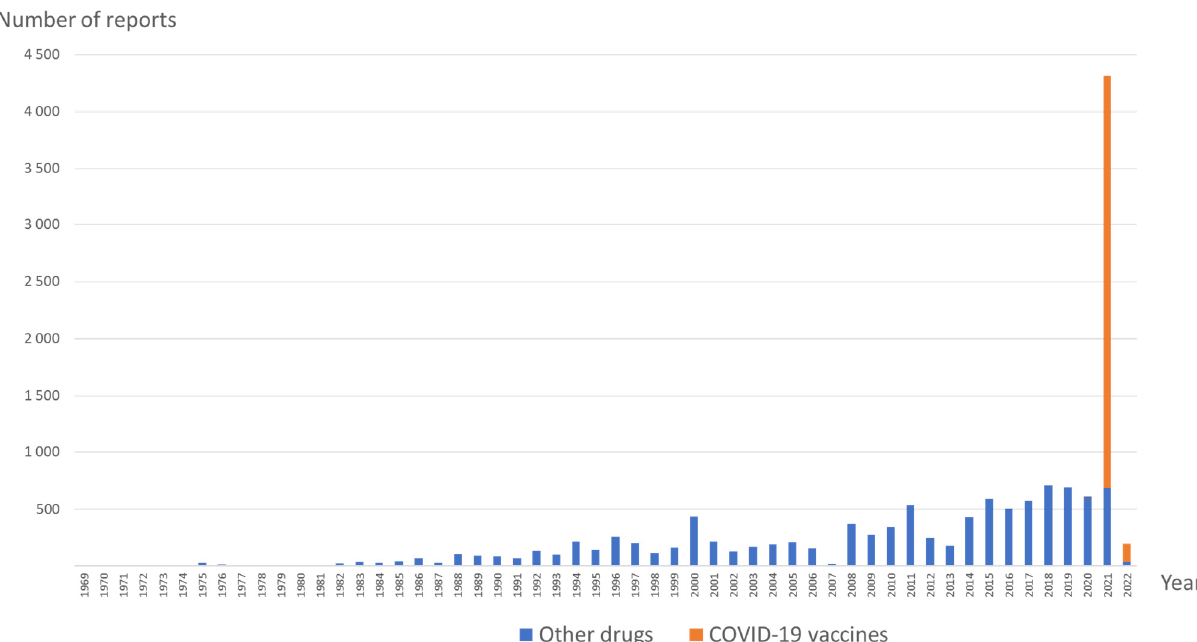
Figure 1. Prevalence of parosmia reports involving COVID-19 vaccines and other drugs over time. Table 2. Characteristics of the reports of patients with parosmia (COVID-19 vaccines vs. other drugs).